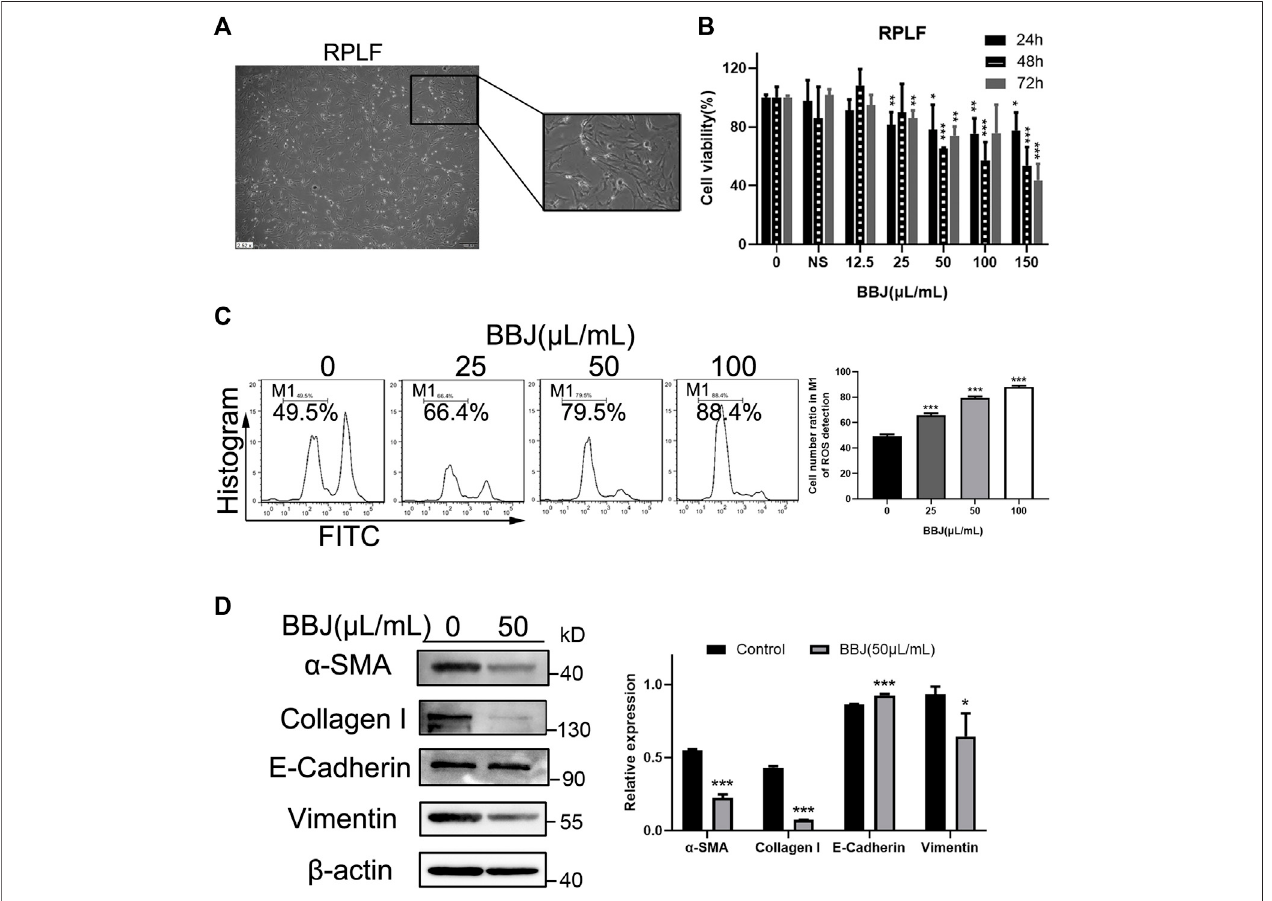
FIGURE 3 | The inhibitory effect of BBJ in RPLF. (A) Cell morphology of RPLF was photographed by an inverted microscope (×10). (B) RPLFs were treated with BBJ or normal saline for24, 48,and 72 h. Cell viabilitywasdetectedbyMTTtests. (C) ROSinRPLF wasanalyzedafter 24 h treatment ofBBJ or NS. (D) Expressionsof α -SMA,E-cadherin,vimentin,collagen-I,and β -actininRPLFweredeterminedbywesternblotassay.ProteinexpressionsweretreatedstatisticallybyImageJ.* p < 0.05; ** p < 0.01; *** p < 0.001 versus the control